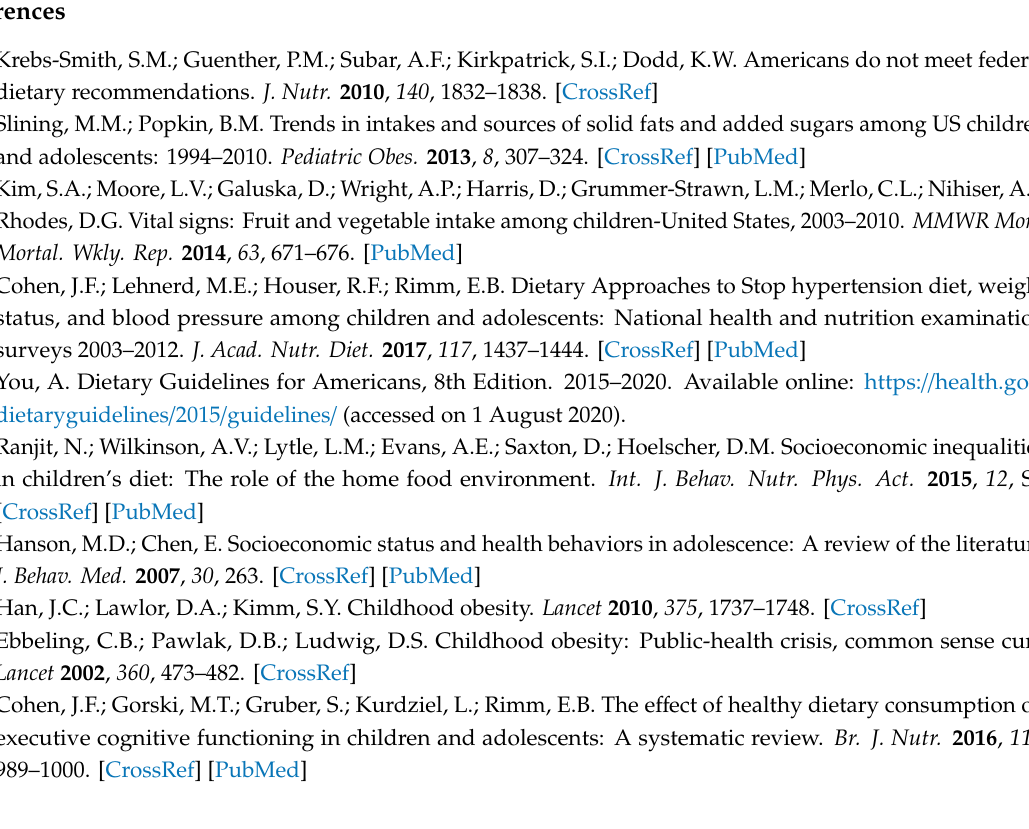
Table S1: Average nutrient values for intervention and standard meals provided to students participating in a feeding